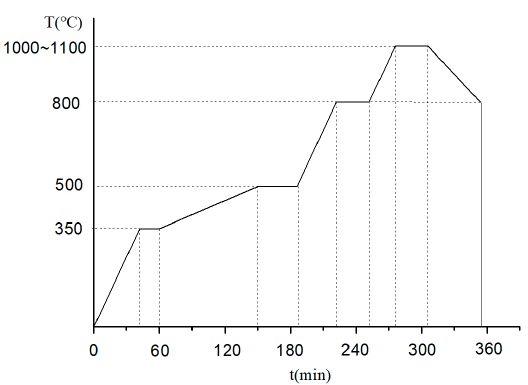
Figure 4. Welding process curve.